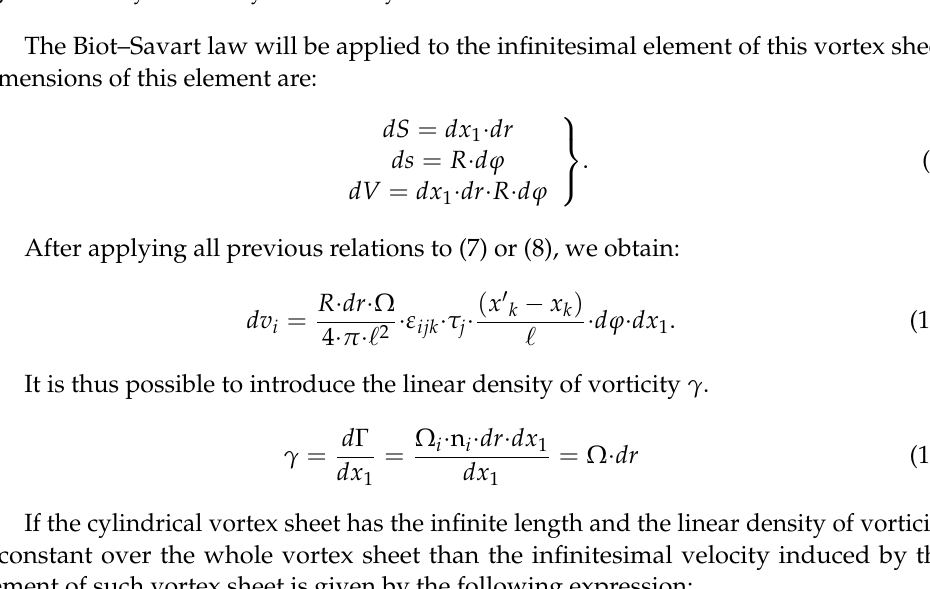
Figure 2. Velocity induced by an infinite cylindrical vortex sheet.